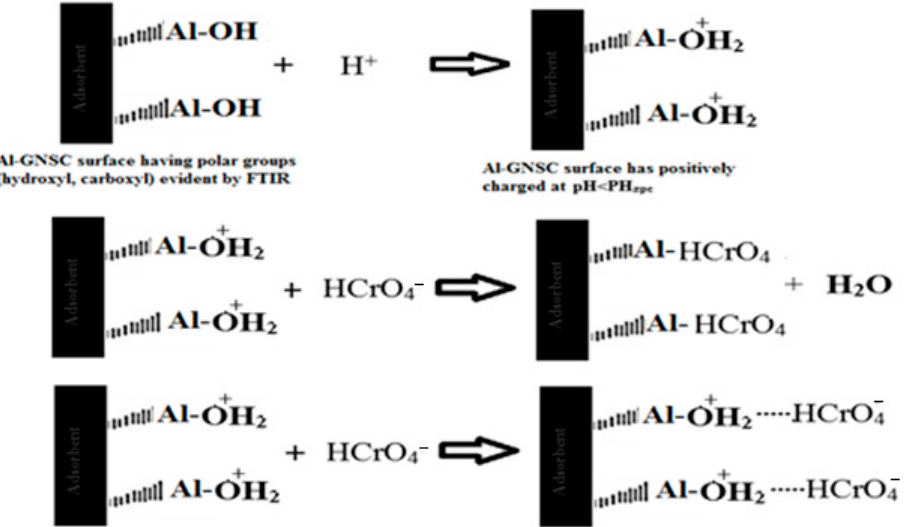
Figure 9. Possible mechanism of the adsorption of chromium ions by Al-GNSC.